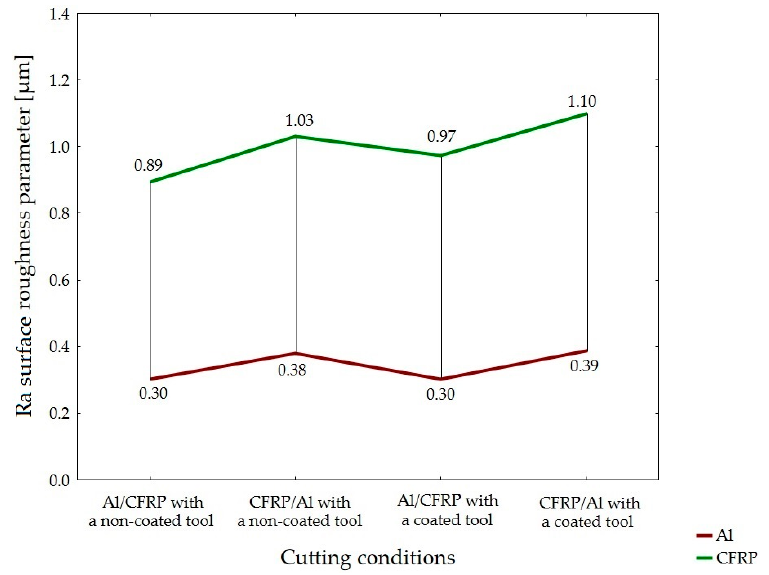
Figure 11. Surface uniformity based on the value of Ra surface roughness parameter obtained depending on the machining configuration and the type of tool.